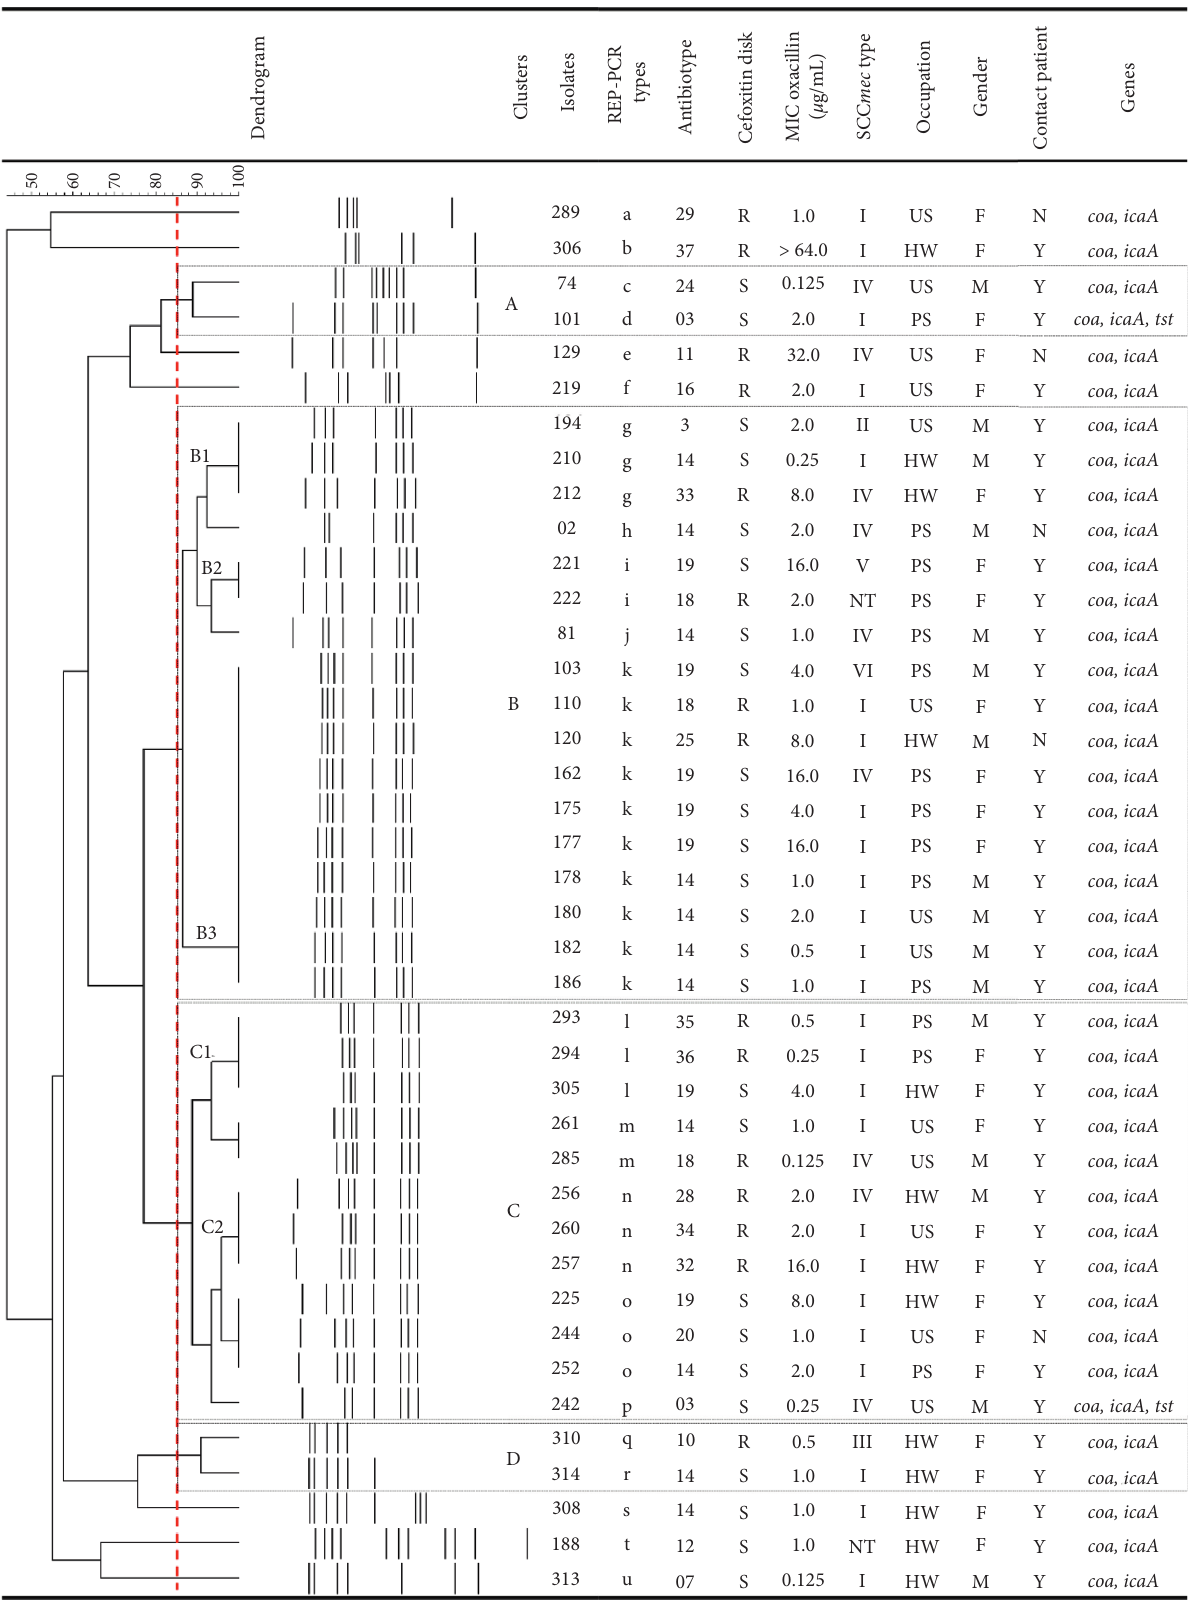
Figure 2: Phenotypic and molecular characteristics of 40 methicillin-resistant Staphylococcus aureus (MRSA, mecA positive) and descriptive variables of MRSA carriers. The UPGMA banding pattern obtained by REP-PCR based on Dice similarity coefficient showing the genetic relatedness of MRSAs. Vertical dashed line marks the position of similarity coefficient value of 0.85. REP-PCR: repetitive element sequence based-polymerase chain reaction; MIC: minimal inhibitory concentration; R resistant; S susceptible; SCC mec : staphylococcal cassette chromosome mec ; NT: nontypeable; HW: healthcare worker; US: undergraduate student; PS: postgraduate student; F: female; M: male; N: no; Y: